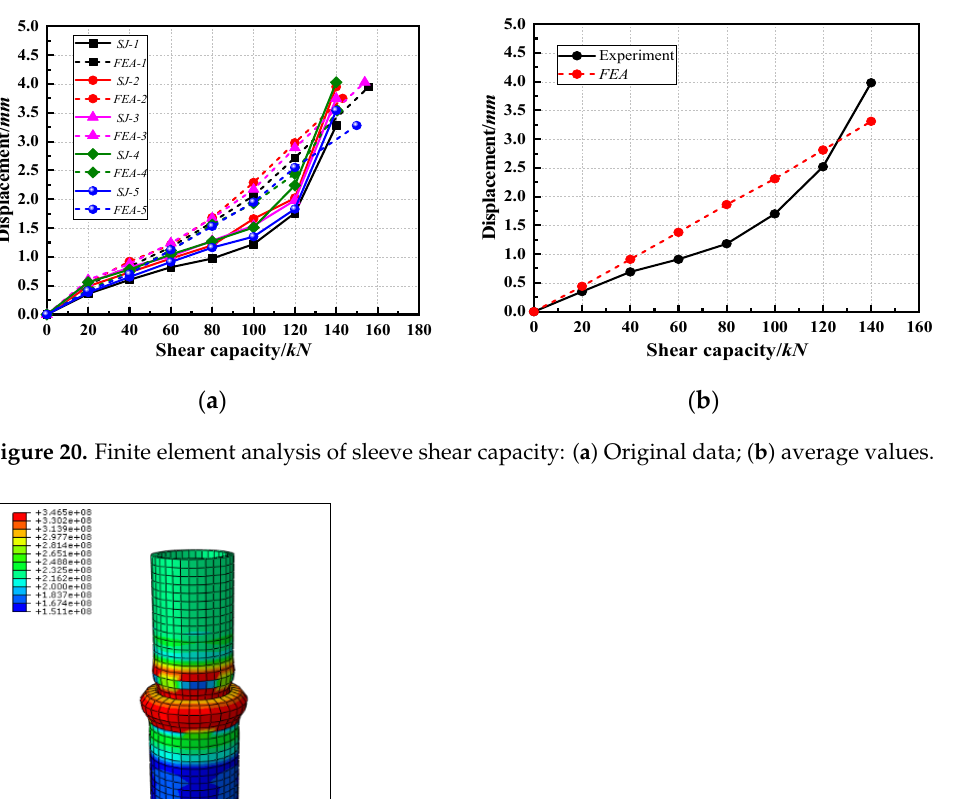
Figure 19. Model of a sleeve shear.